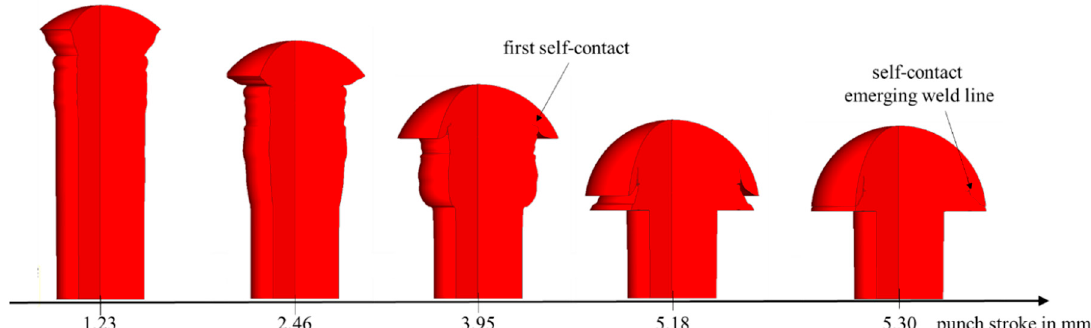
Figure 13. Material flow during hot air staking with a heating time t E of 3 s for three-quarter model of the rivet pin.